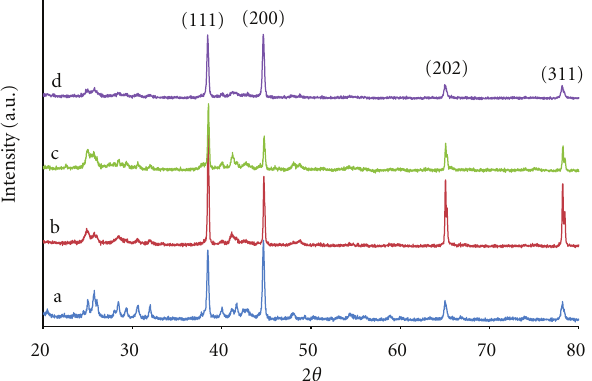
Figure 3: XRD analysis of BTO calcined at (a) 450 ◦ C, (b) 500 ◦ C, (c) 550 ◦ C, and (d) 800 ◦ C.